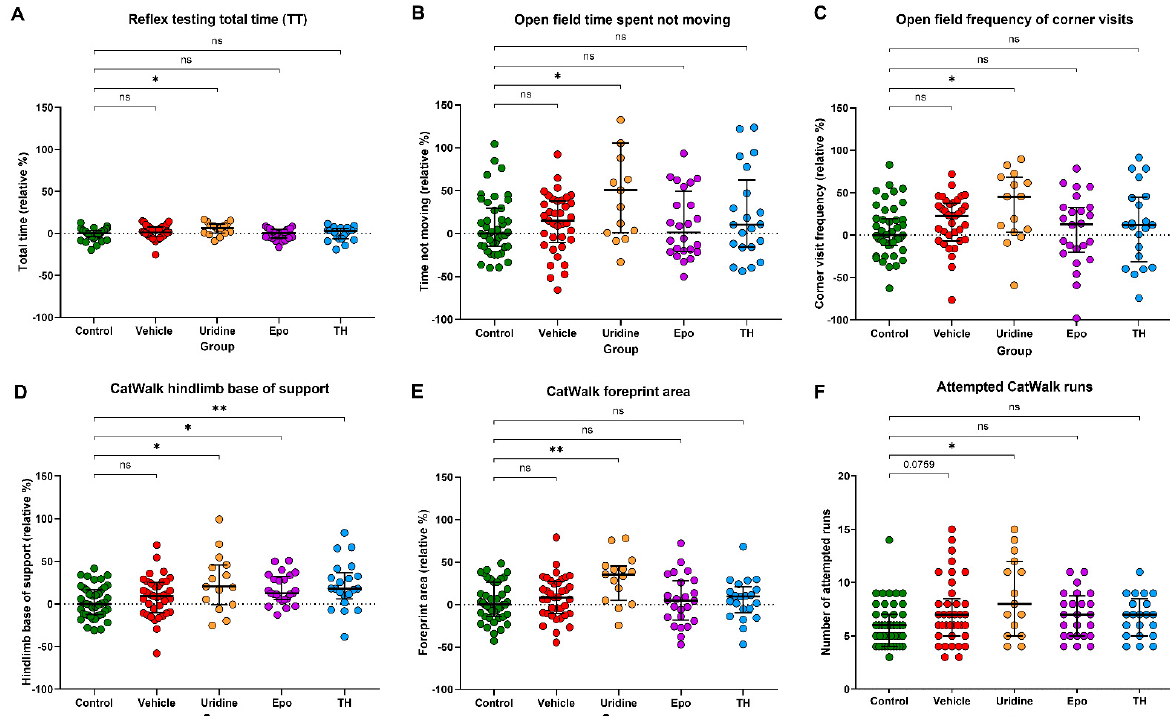
Figure 2. Motor development. ( A ) AUC analysis of the total time (median; IQR) to complete all reflex tests showed that Ur animals (8263.3 s · days; 7782.8–8658.0 s · days) took significantly longer to complete reflex testing compared to control animals (8083.3 s · days; 7690.5–8486.2 s · days) throughout the testing period. ( B ) Frequency of open field corner visits in the Veh, Ur, Epo, and TH groups relative to the control group. Median corner visit frequency in controls was 49. Median values were significantly increased in the Ur group by 45.5% and non–significantly increased in all other HIH–exposed groups relative to control median. ( C ) Time in seconds (s) spent not moving in open field in the Veh, Ur, Epo, and TH groups relative to the control group. Median time spent not moving was 99.7 s in the control group and significantly increased in the Ur group by 50.7%. In all other HIH groups, median time spent not moving was non–significantly increased. ( D ) Hindlimb BOS in the Veh, Ur, Epo, and TH relative to the control median. Median hindlimb BOS was 0.01 cm/g in the control group and was significantly increased in the Ur, Epo, and TH groups by 20.3, 12.5, and 18.0%. ( E ) Foreprint area in the Veh, Ur, Epo, and TH groups relative to the control median. Median foreprint area was 0.39 cm/g in the control group and significantly increased by 35.6% in the Ur group. In all other HIH–exposed groups, median foreprint area was non–significantly increased. ( F ) Number of attempted runs in the control, Veh, Ur, Epo, and TH groups. The median number of attempted runs was 6 in the control group and significantly increased to 8 in the Ur group. All other HIH groups had non–significant increases in number of attempted runs. * Denotes p –value < 0.05, ** denotes p –value < 0.01, and ns denotes no significant difference.